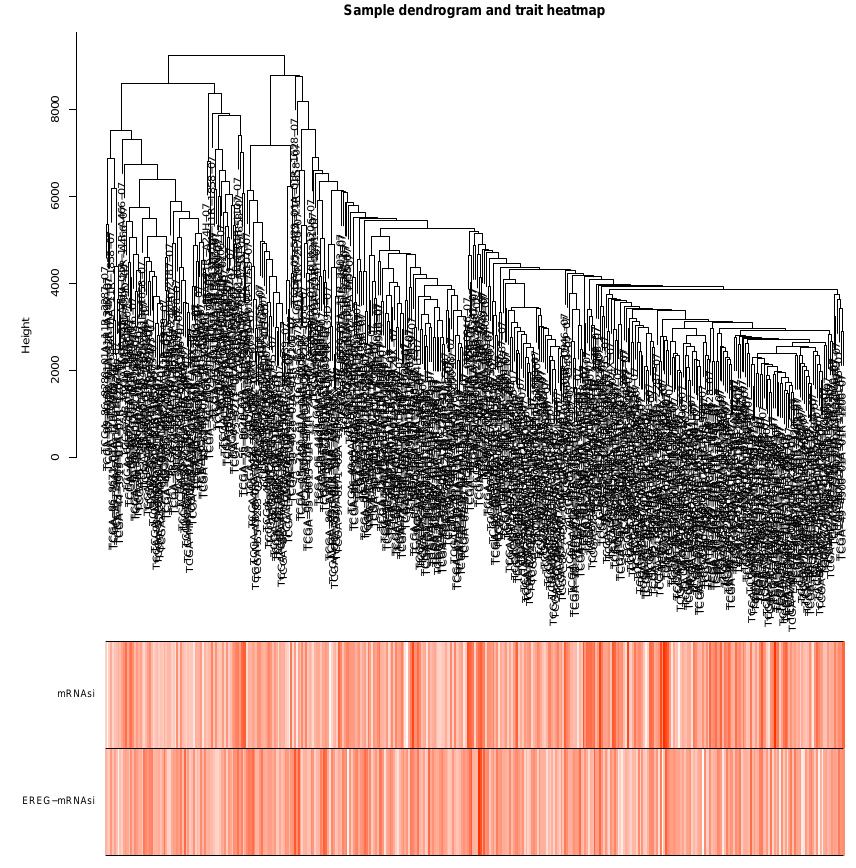
Figure A2. The heat-map of the general data showed an overview of the mRNAsi values and the EREG-mRNAsi